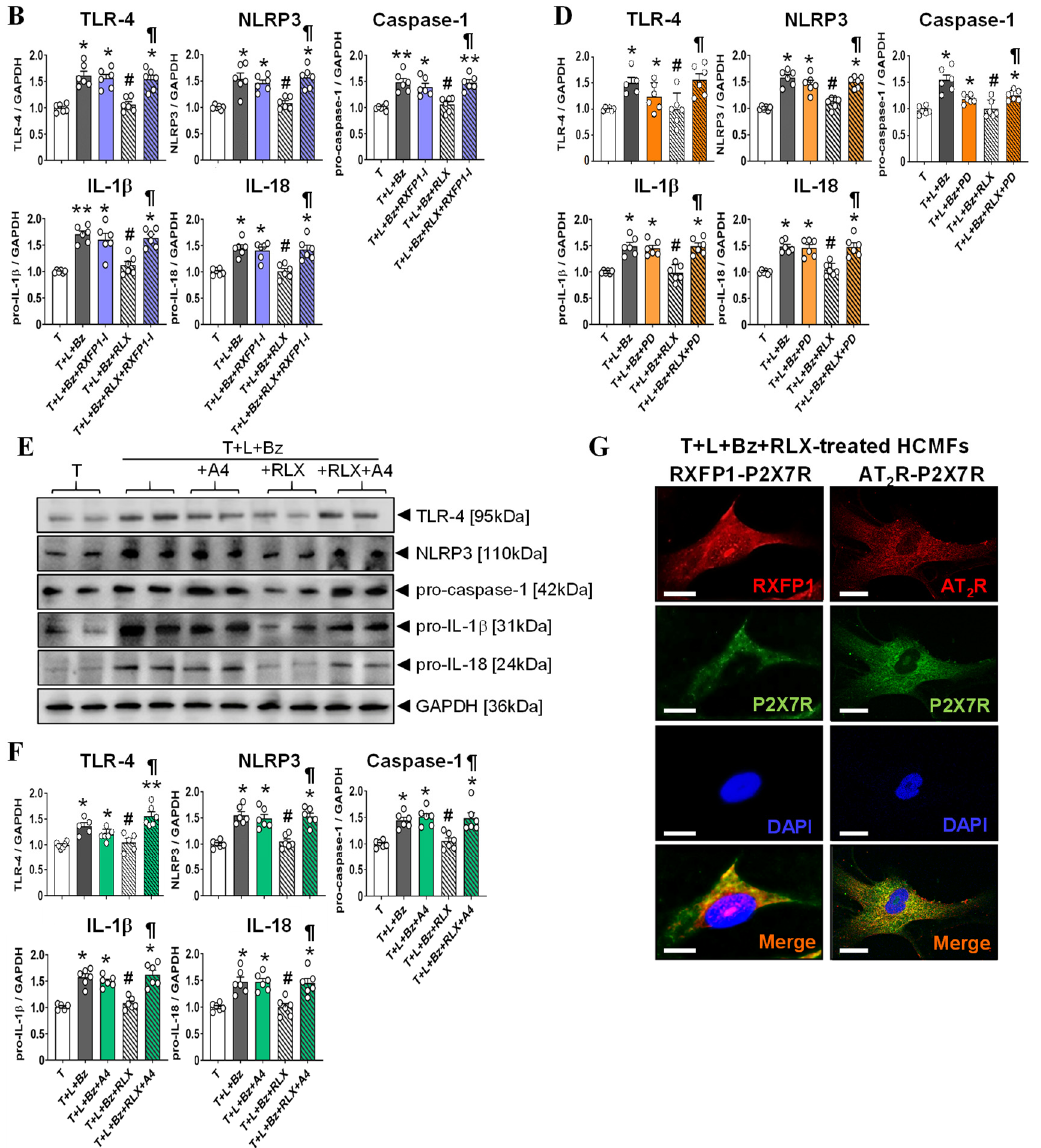
Figure 3. The effects of RLX ± the RXFP1 inhibitor (RXFP1-I), AT 2 R inhibitor (PD) or P2X7R inhibitor (A4) on the T+L+Bz-stimulated increase in TLR-4, NLRP3, pro-caspase-1, pro-IL-1 β and pro-IL-18 levels from HCMFs. ( A , C , E ) Representative Western blots of TLR-4, NLRP3, pro-caspase-1, pro-IL- β and pro-IL-8 expression from HCMFs treated with TGF- β 1 (T), T+L+Bz, T+L+Bz+RXFP1-I, T+L+Bz+RLX or T+L+Bz+RLX+RXFP1-I ( A ); T, T+L+Bz, T+L+Bz+PD, T+L+Bz+RLX or T+L+Bz+RLX+PD ( C ); or T, T+L+Bz, T+L+Bz+A4, T+L+Bz+RLX or T+L+Bz+RLX+A4 ( E ), after 8 h. ( B , D , F ) Also shown are the mean ± SEM of each end point measured from each treatment group studied, corrected for GAPDH (house-keeping protein) loading, and expressed relative to the value in the T-stimulated cell group, which was expressed as 1 in each case, from n =6 separate experiments conducted in duplicate. The individual data sets for each group are represented by the white circles within each set of bar graphs. ( G ) Representative immunofluorescence staining of RXFP1, AT 2 R and P2X7R, and colocalization of RXFP1 and P2X7R or AT 2 R and P2X7R in HCMFs. Scale bar = 20 µ m. Nuclear staining was performed using DAPI, whilst merged images demonstrated that all three receptors were expressed by HCMFs. * p < 0.05, ** p < 0.01 compared to the T alone group; # p < 0.05 compared to the T+L+Bz group; ¶ p < 0.05 compared to the T+L+Bz+RLX